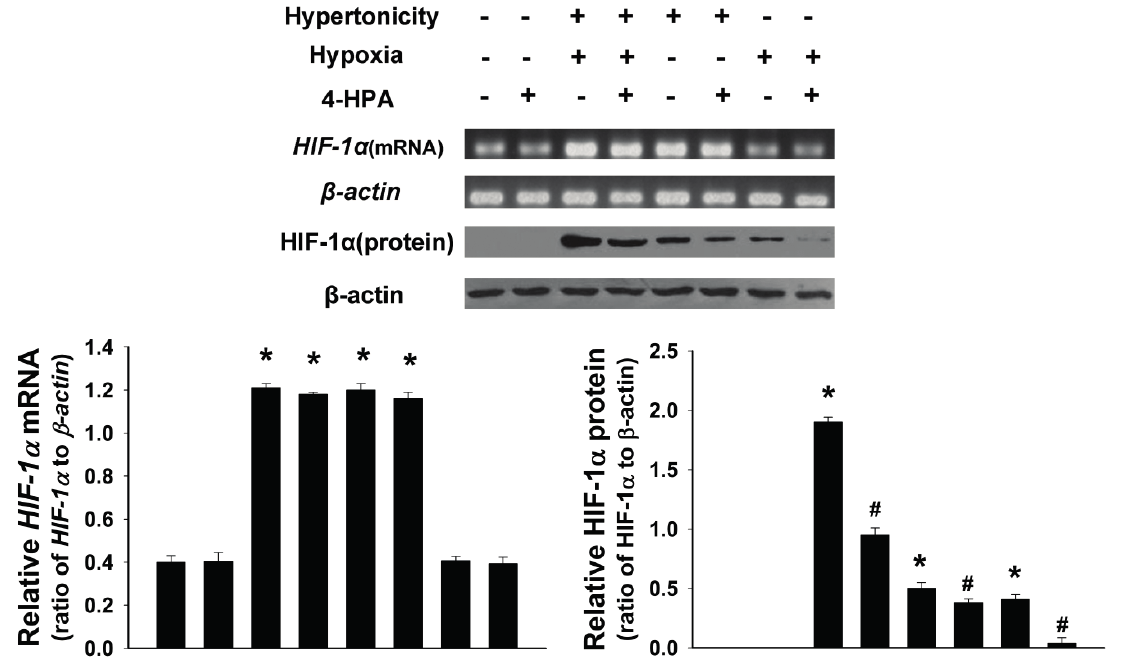
Figure 5. Effects of 4-HPA on hypertonicity, hypoxia, and both of the two induced HIF-1 α protein and mRNA levels in primary AEC. Treated by hypertonicity, hypoxia, or both of the two with or without 4-HPA treatment for 4 h, primary rat alveolar epithelial cells (AEC) were harvested and HIF-1 α protein and mRNA levels were assessed by Western blotting and RT-PCR. The ratios of HIF-1 α to β -actin in protein and mRNA levels from three independent experiments were obtained by density scanning of the Western blotting and PCR band using an image analysis system. Data are means ± SD, * p < 0.05 vs. control group, # p < 0.05 vs. the groups with stimuli or stimulus in the absence of 4-HPA treatment.